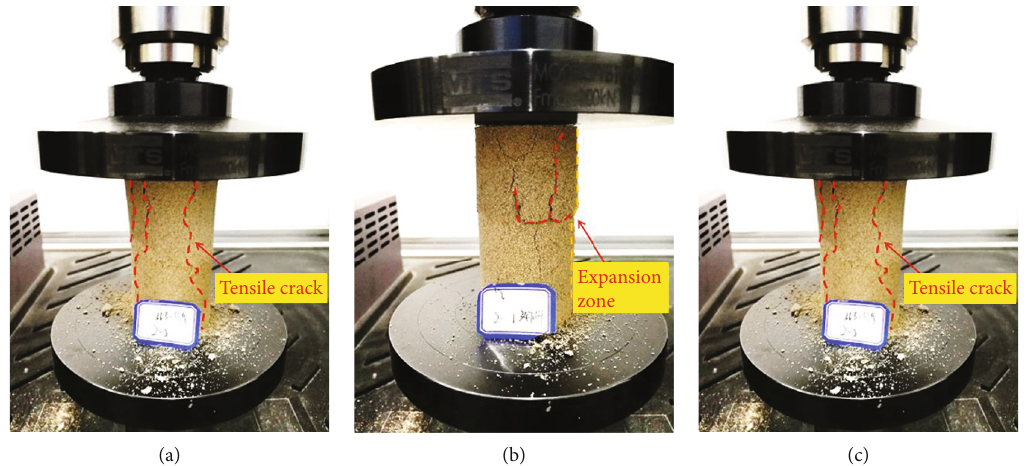
Figure 8: Three typical failure modes of the uniaxial compression test: (a) shear failure of the single inclined plane, (b) expansion failure, and (c) split tensile